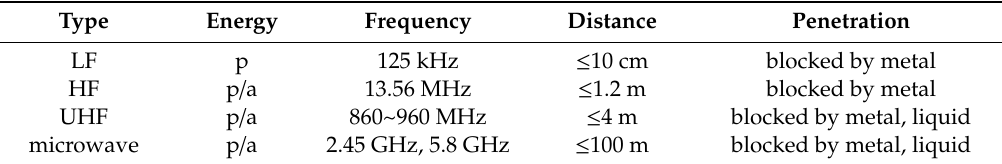
Table 2. Summary of di ff erent types of RFID. Here p represents passive and a represents